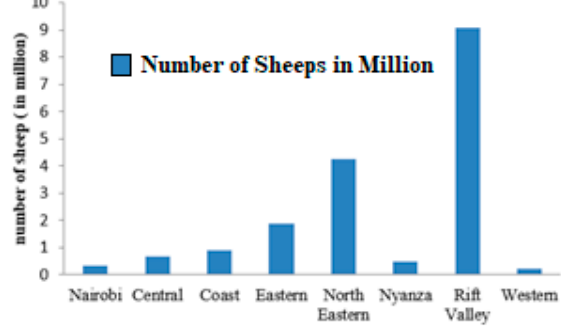
Figure 2. The number of sheep in all provinces of Kenya.